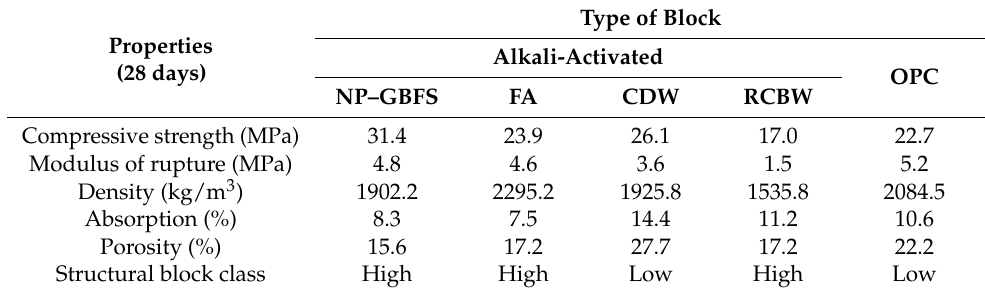
Table 5. Characteristics and properties of the produced blocks (alkali-activated and OPC